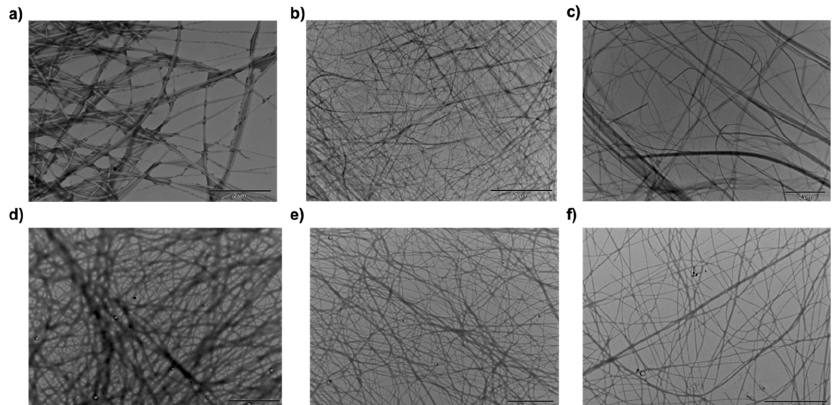
Figure 4. TEM images of MA- L -Phe-OH and MA- D -Phe-OH. ( a – c ) Three-dimensional fibrous network of MA- L -Phe-OH, and ( d – f ) three-dimensional fibrous network of MA- D -Phe-OH. The scale bar is 2 µ m for all images except ( b ), which is 5 µ m.